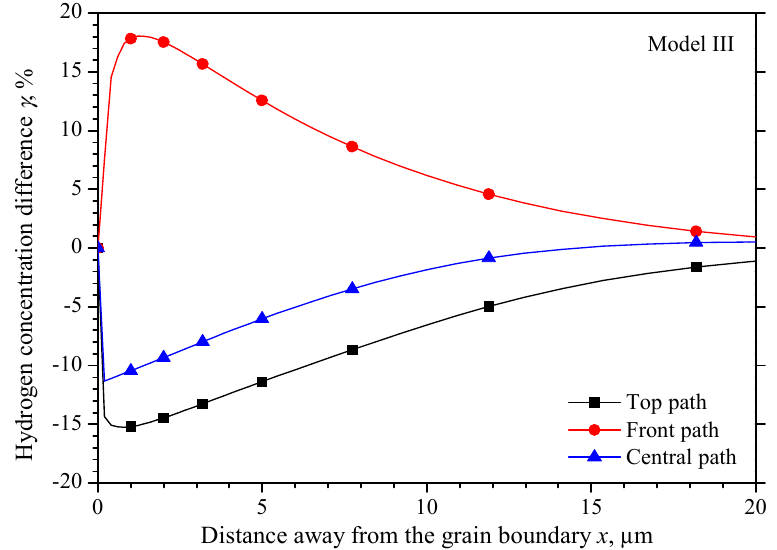
Figure 13. Hydrogen concentration difference equidistant from the grain boundary of model III.